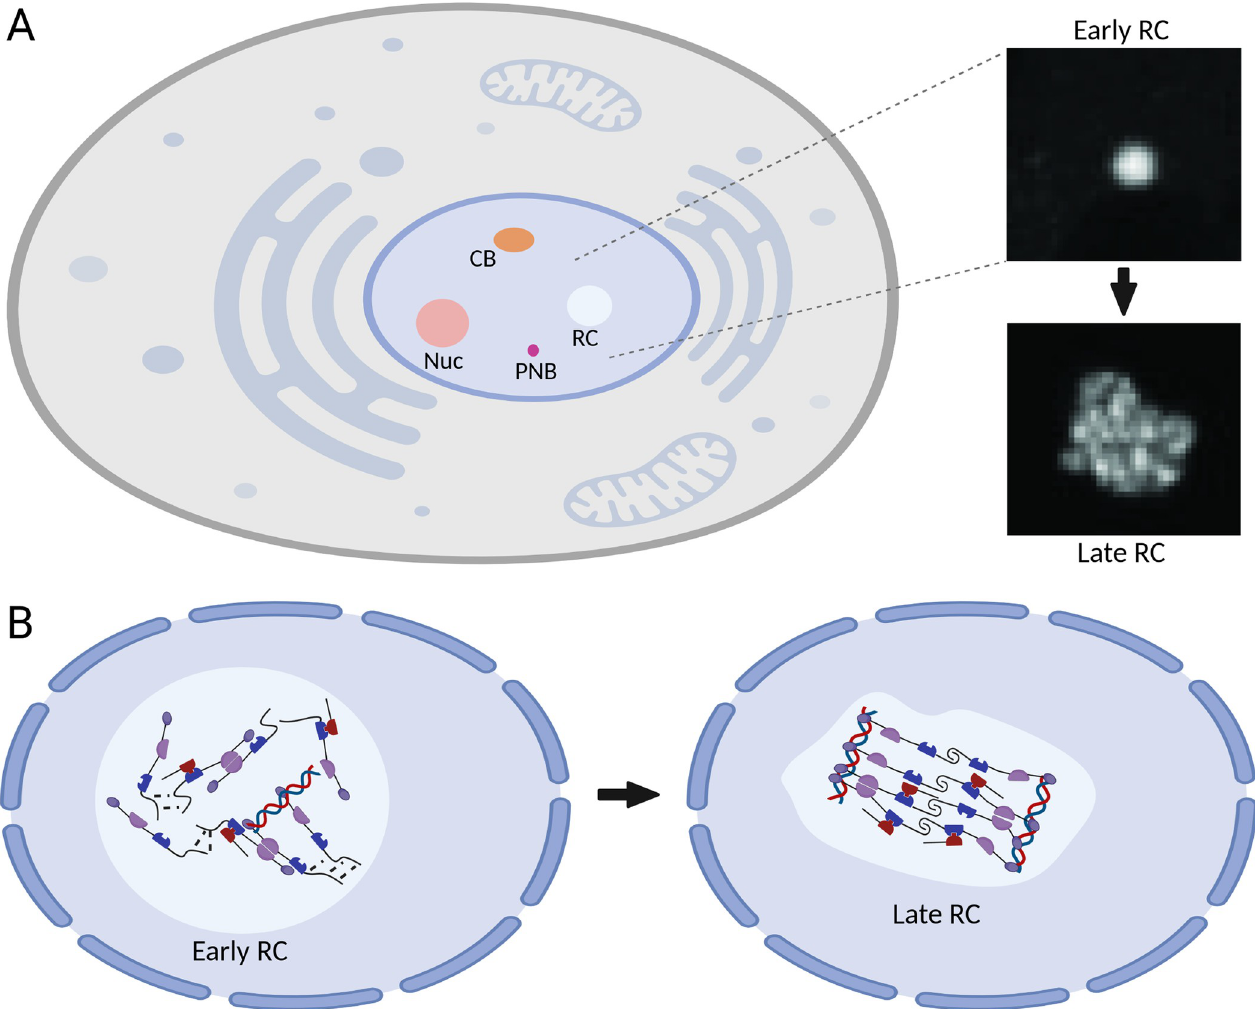
Fig 2. Maturation of viral replication compartments. (A) The nucleus contains membrane-less compartments such as Nuc, CBs, PML-NBs (PNB), and RCs of DNA viruses. In the case of HCMV [25], early RCs exhibit fluid properties consistent with being formed by LLPS. After the onset of viral DNA replication, these properties change, resulting in the hardening of late RCs. (B) Hypothetical model. In early RCs, weak and transient interactions predominate, resulting in fluid properties (left). In late RCs, the increased quantity of viral DNA, accumulation of client proteins, and posttranslational modifications of the scaffold proteins may result in tighter interactions of the molecules and the formation of more ordered molecular assemblies (right). Created with Biorender.com. CB, Cajal body; HCMV, human cytomegalovirus; LLPS, liquid–liquid phase separation; Nuc, nucleoli; PML-NB, promyelocytic leukemia nuclear body; RC, replication